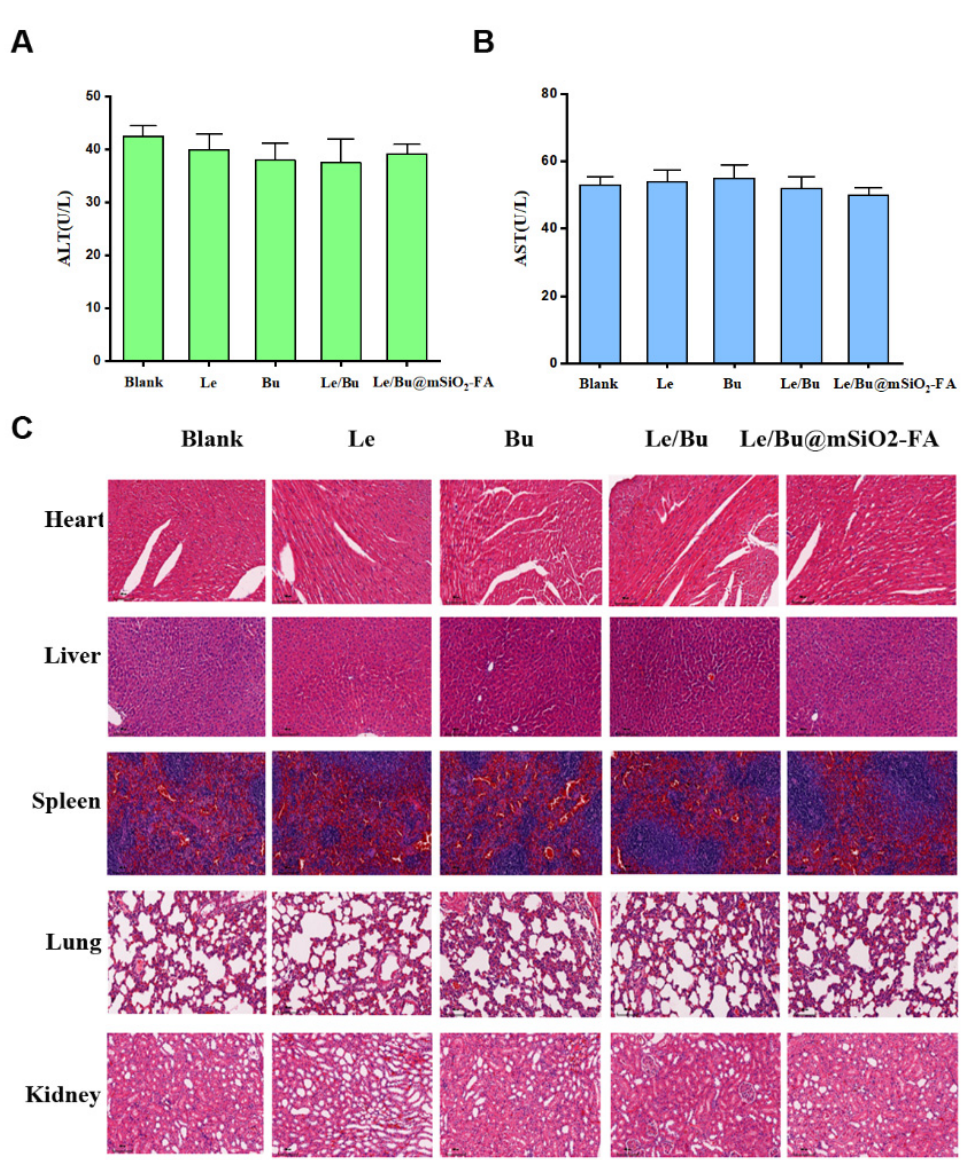
Figure 7. ( A , B ) Hematological analysis of the function of liver and heart in heathy mice treated with saline, Le, Bu, Le/Bu, and Le/BumSiO 2 -FA. ( C ) H&E staining of the heart, liver, spleen, lung and kidney after treatment with saline, Le, Bu, Le/Bu, and Le/BumSiO 2 -FA. N = 3 of each group.